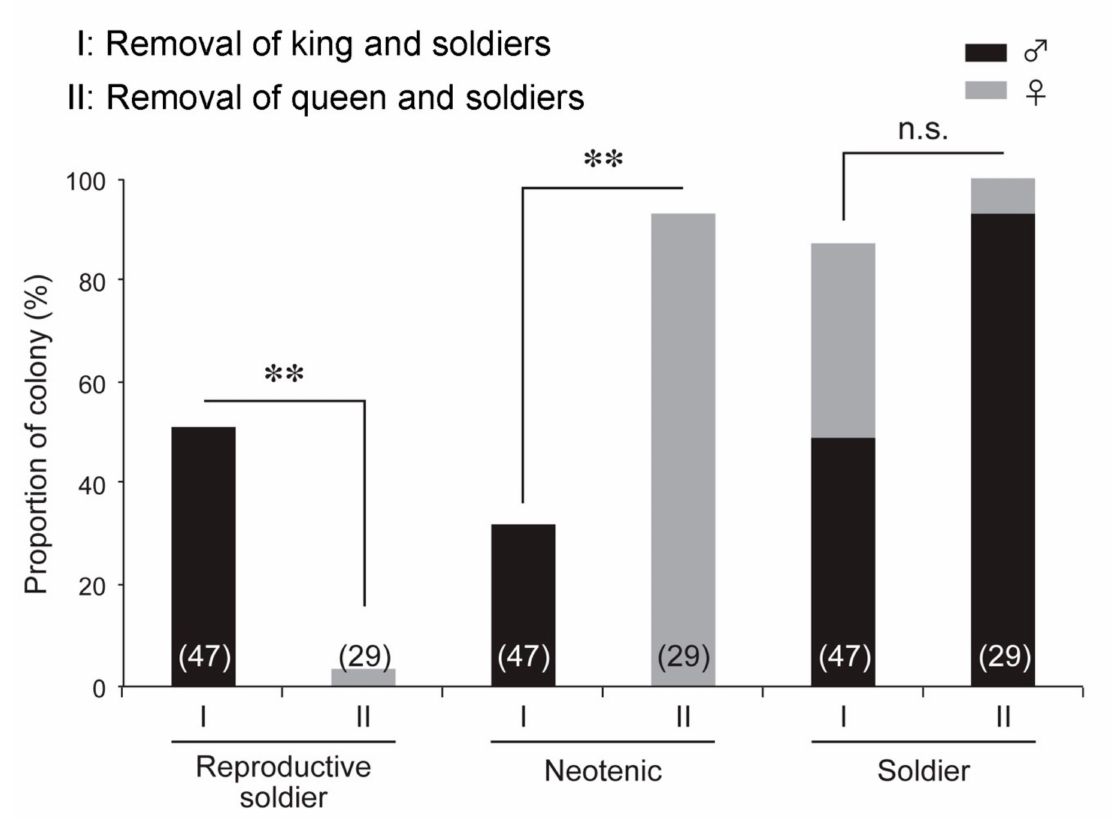
Figure 4. Colony proportions of three castes (reproductive soldiers, neotenics, and soldiers) after the removal of the king and soldiers (I) or the queen and soldiers (II). The numbers of colonies examined are indicated in parentheses. Asterisks denote significant differences (Fisher’s exact test, ** p < 0.01, not significant